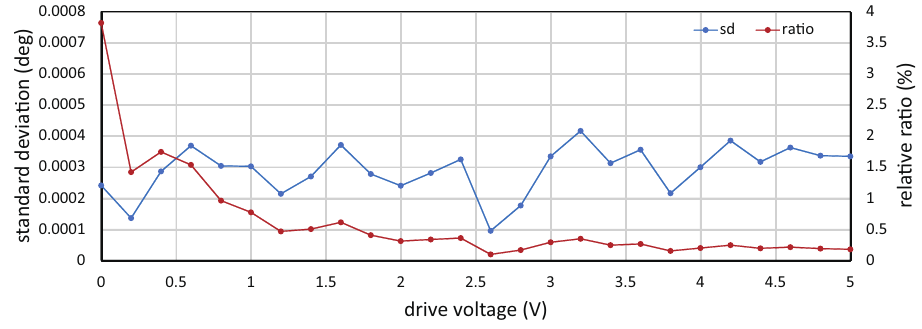
Figure 10. Relationship between drive voltage and the standard deviation of vibration